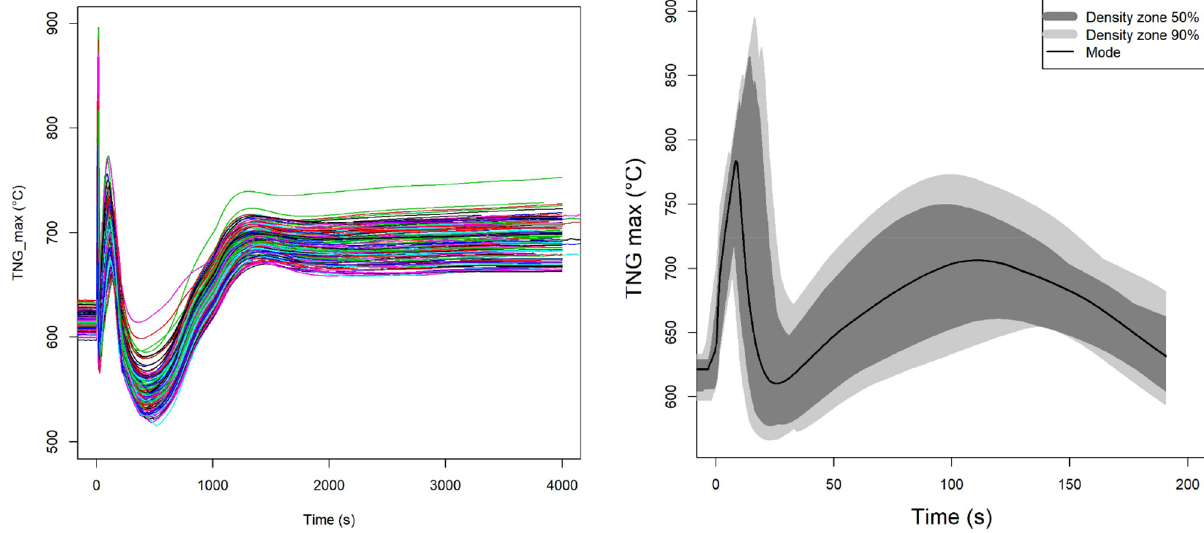
Fig. 5. Evolution of the maxima of clad temperatures for the 136 simulated scenarios of USBO transient (left) and zoom on the fi rst peak using HDR-based visualizations